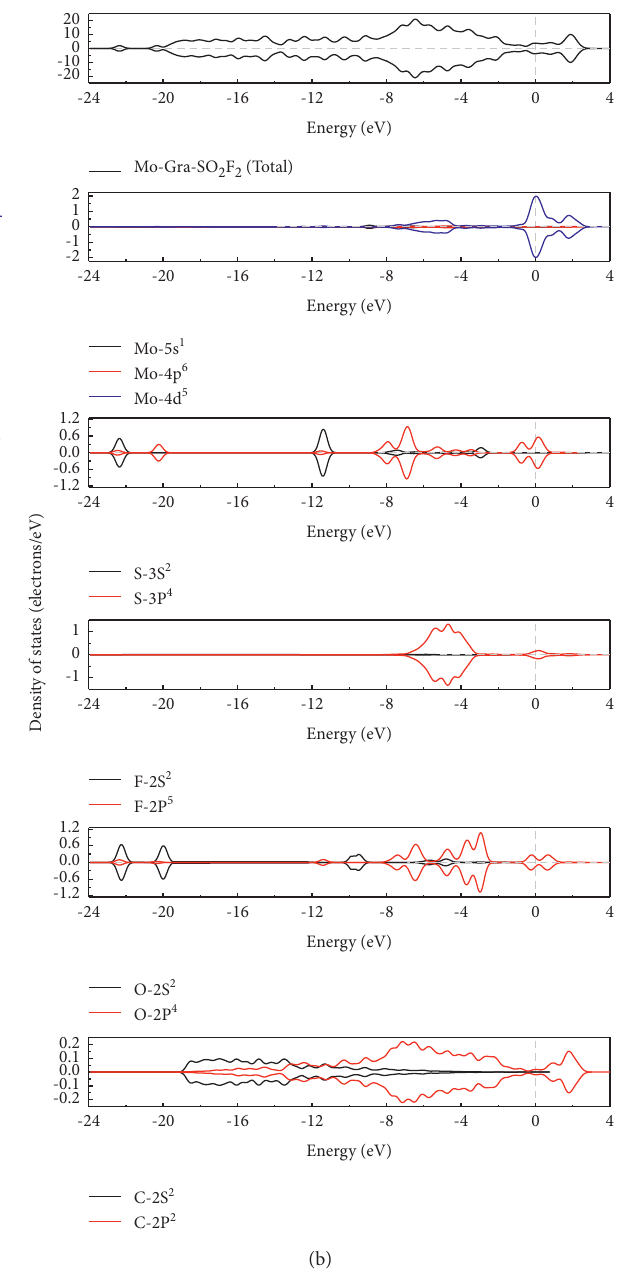
Figure 7: Density of states: (a) density of spin states before and after adsorption of SO 2 F 2 on intrinsic graphene and Mo-doped grapheme and (b) Mo-doped graphene adsorption of SO 2 F 2 gas molecule spin state density of each atom. Table 3: The orbital charge distribution of SO 2 F 2 gas molecules adsorbed by Mo-doped intrinsic graphene. Atoms S track (e) P track